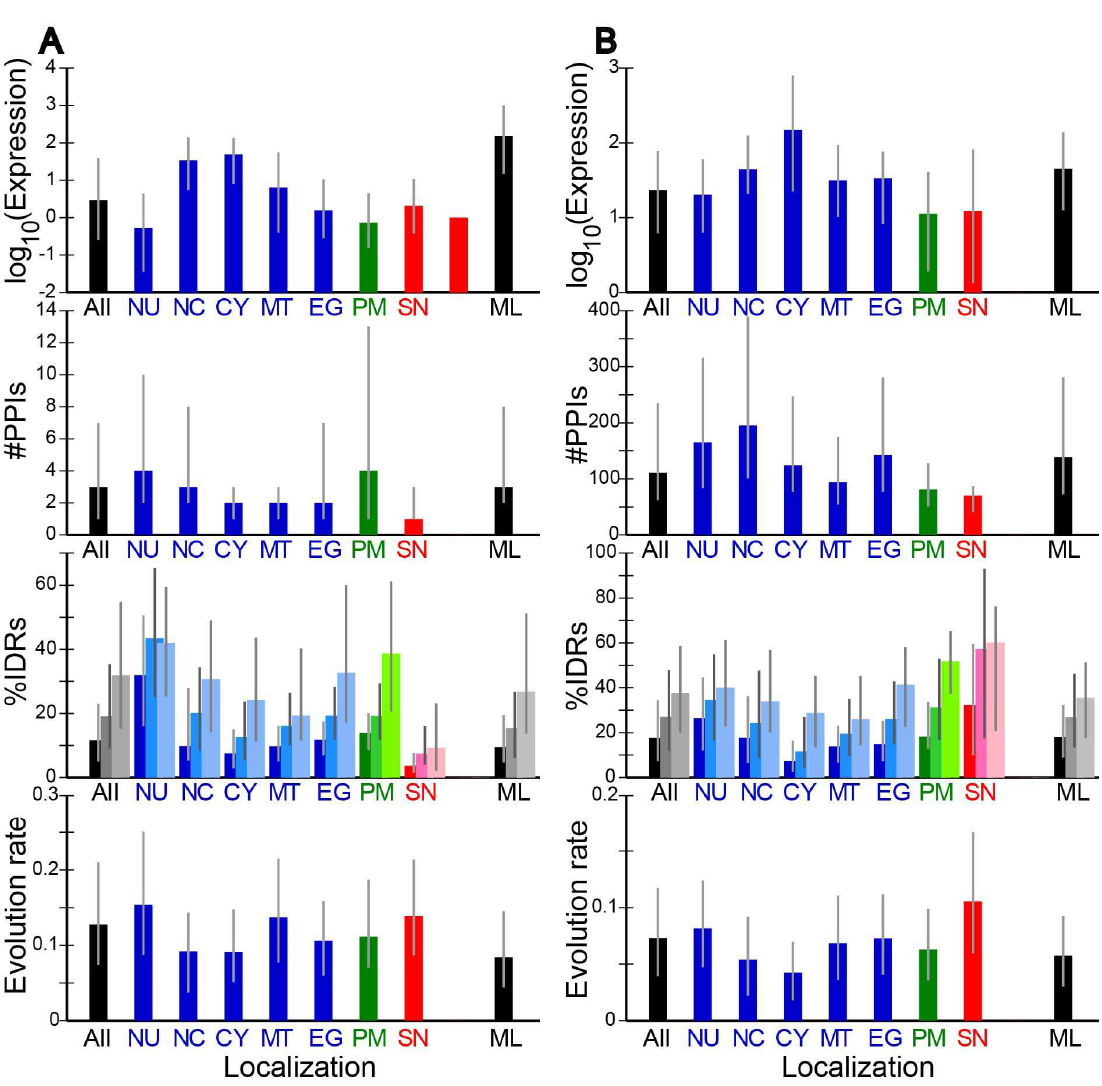
Figure 2. Medians of four quantities in different localizations in two non-mammalian eukaryotes. ( A ) A. thaliana ; ( B ) S. cerevisiae ; the data are presented as in Figure 1.